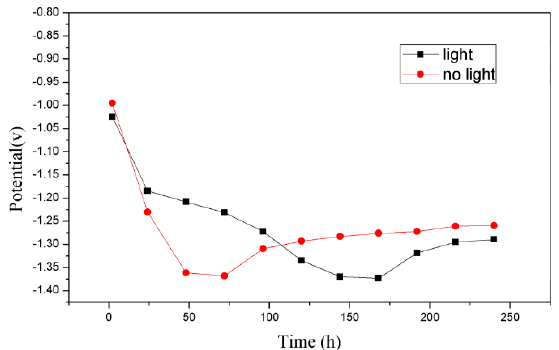
Figure 6. Time-open circuit potential chart of the Zn-Al-Mg-TiO 2 coating in 3.5% NaCl solution under ultraviolet and no ultraviolet conditions (reference electrode: calomel).